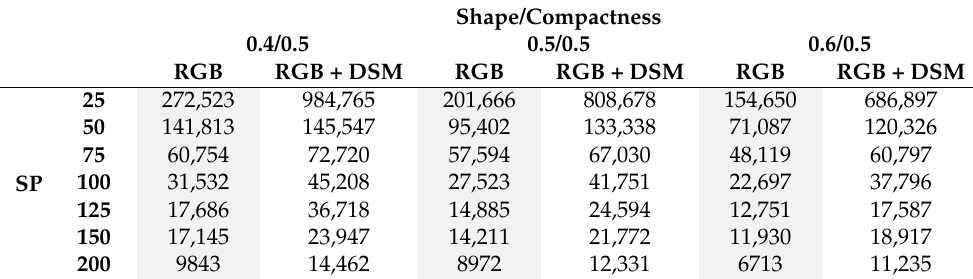
Table 1. Number of resulting segments based on the different segmentation configurations.